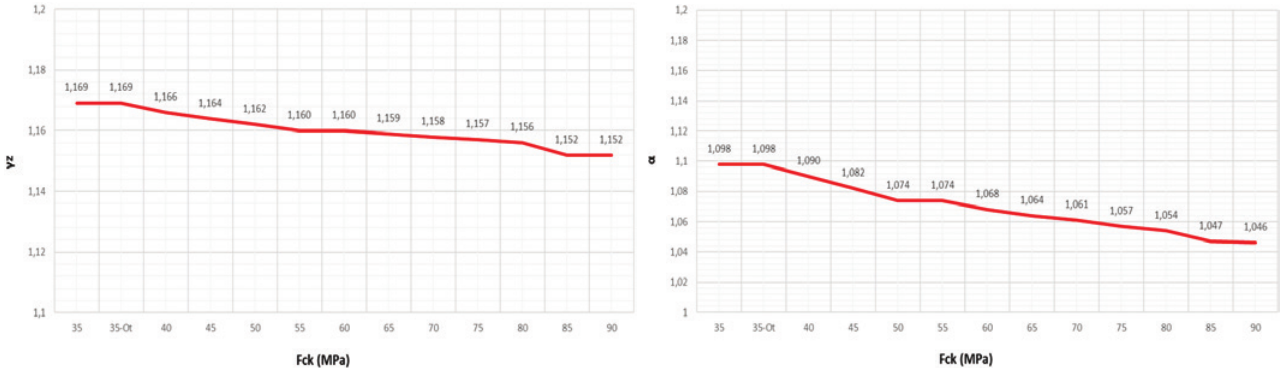
Variation of the γ parameter and the α coefficient in relation to f z